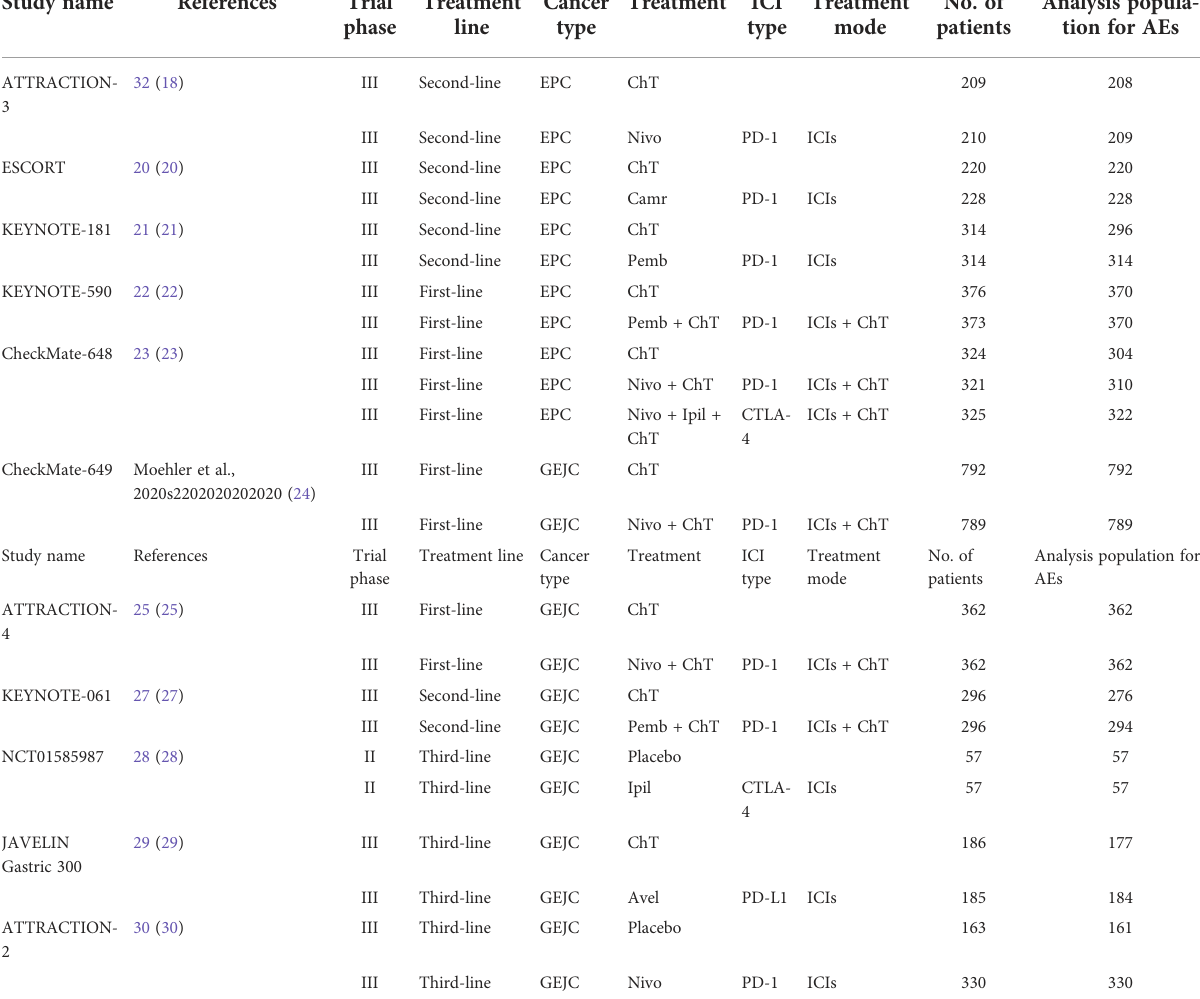
TABLE 1 Characteristics of the included